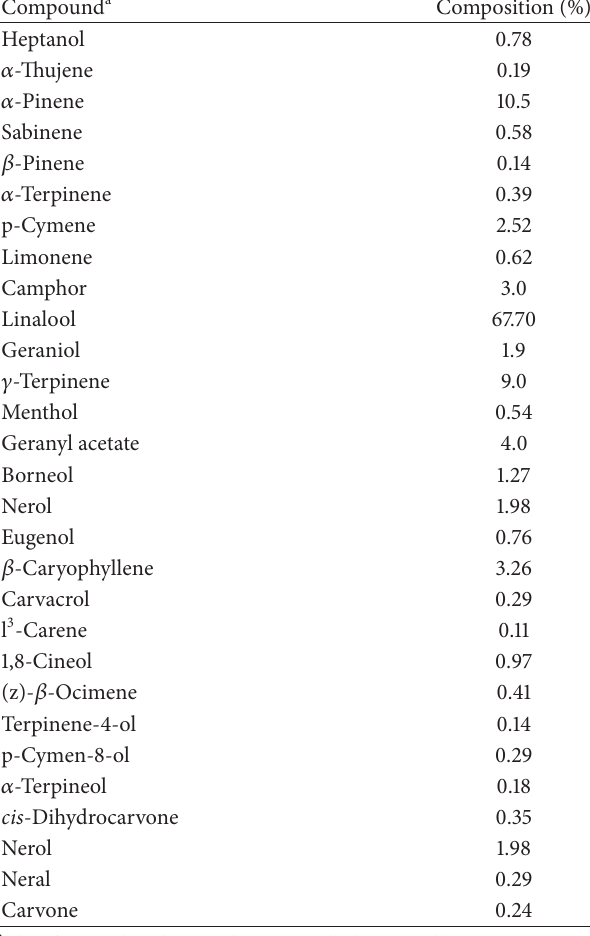
Table1:Chemicalcompositionoftheessentialoilfrom Coriandrum sativum